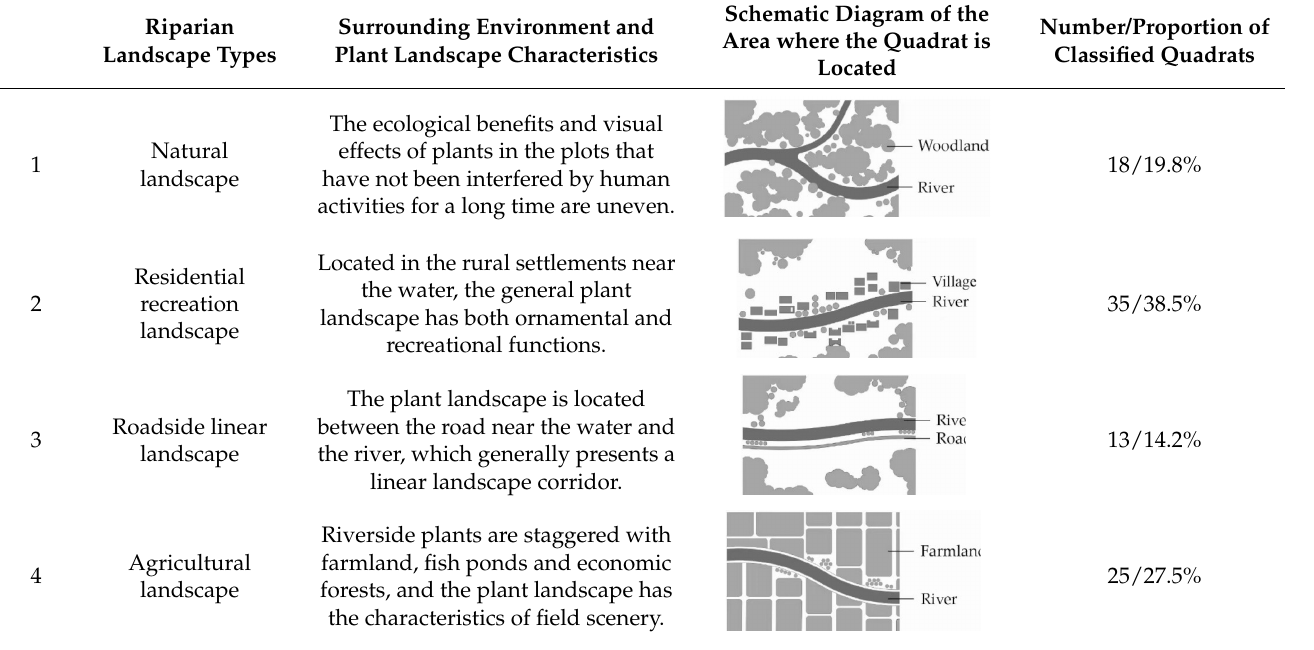
Table 2. Riparian landscape types of rural rivers in the Qingxi area (source: